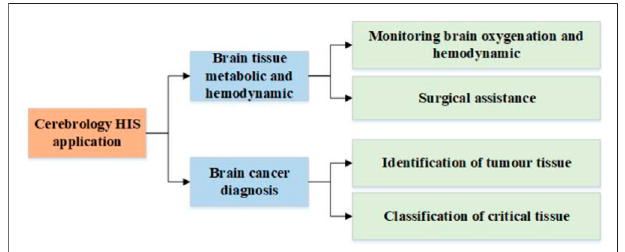
FIGURE 3 | Taxonomy of the current cerebrology HSI